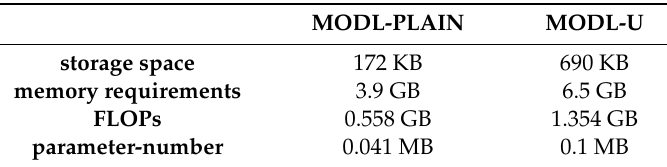
Table 4. Comparison of evaluation indexes of di ff erent